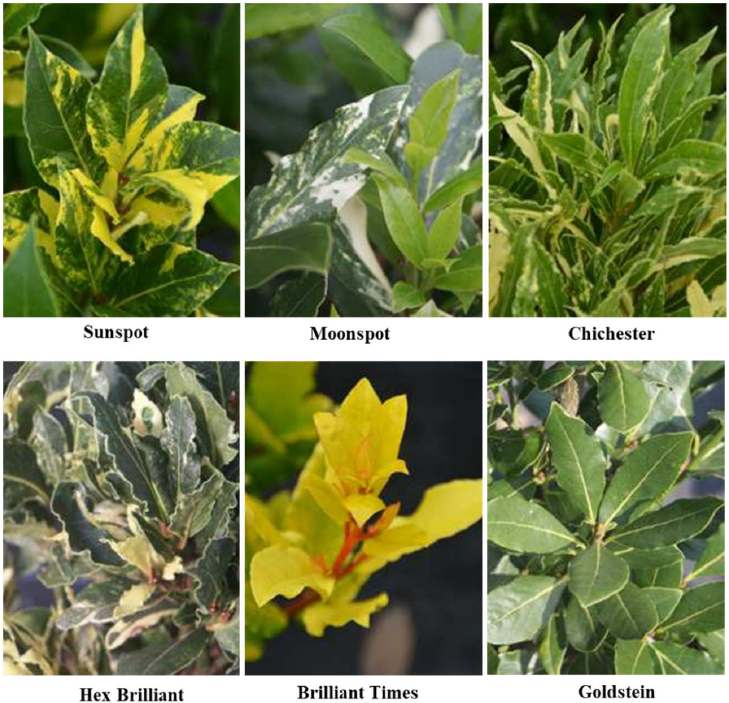
Figure 2. Variation in leaf morphology of some of the L. nobilis L. cultivars. Source: https://sierplant.be/soorten/ (accessed on 3 April 2022).